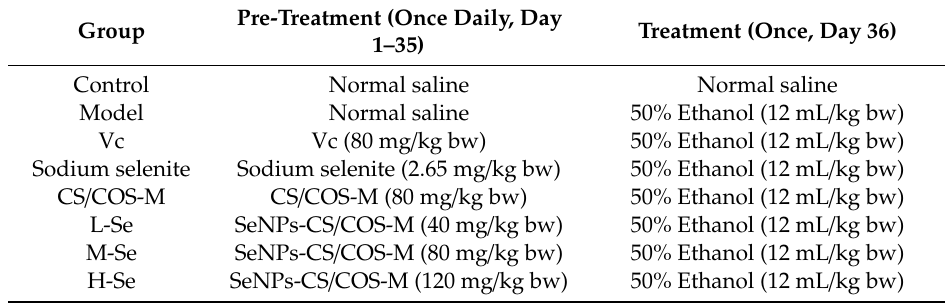
Table 1. Intragastric administration during the ethanol challenge experiment (Kunming (KM) mice, n =